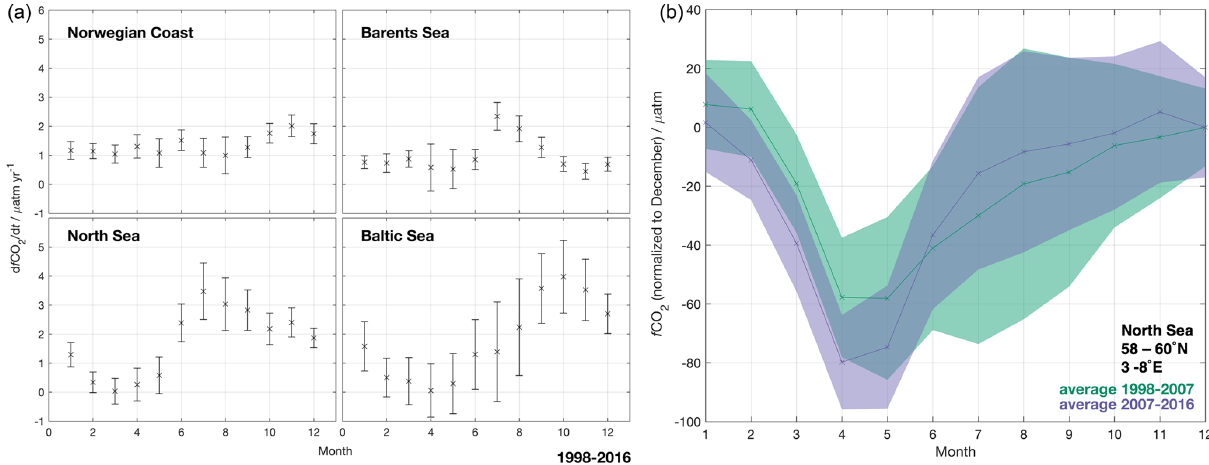
Figure 10. (a) The long-term trend (1998–2016) in surface ocean f CO 2 each month. (b) The average seasonality in f CO 2 for the periods 1998–2007 (green) and 2007–2016 (purple) in the northeastern North Sea (58–60 ◦ N, 3–8 ◦ E), normalized to December. The SD for each month is shown as the shaded